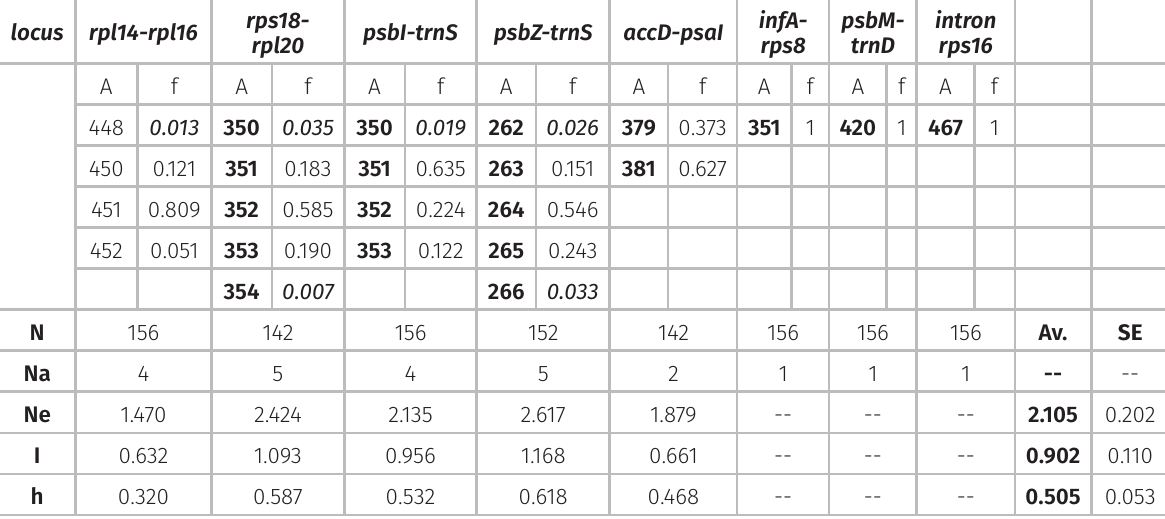
Table V. Chloroplastidic characterization of Ilex paraguariensis individuals with microsatellite markers. rps18- locus rpl14-rpl16 rpl20